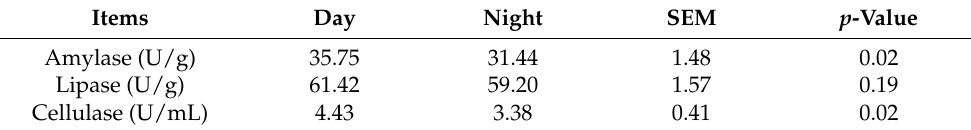
Table 4. The activity of three main enzymes in rumen juice during the day and night (n = 15). Items